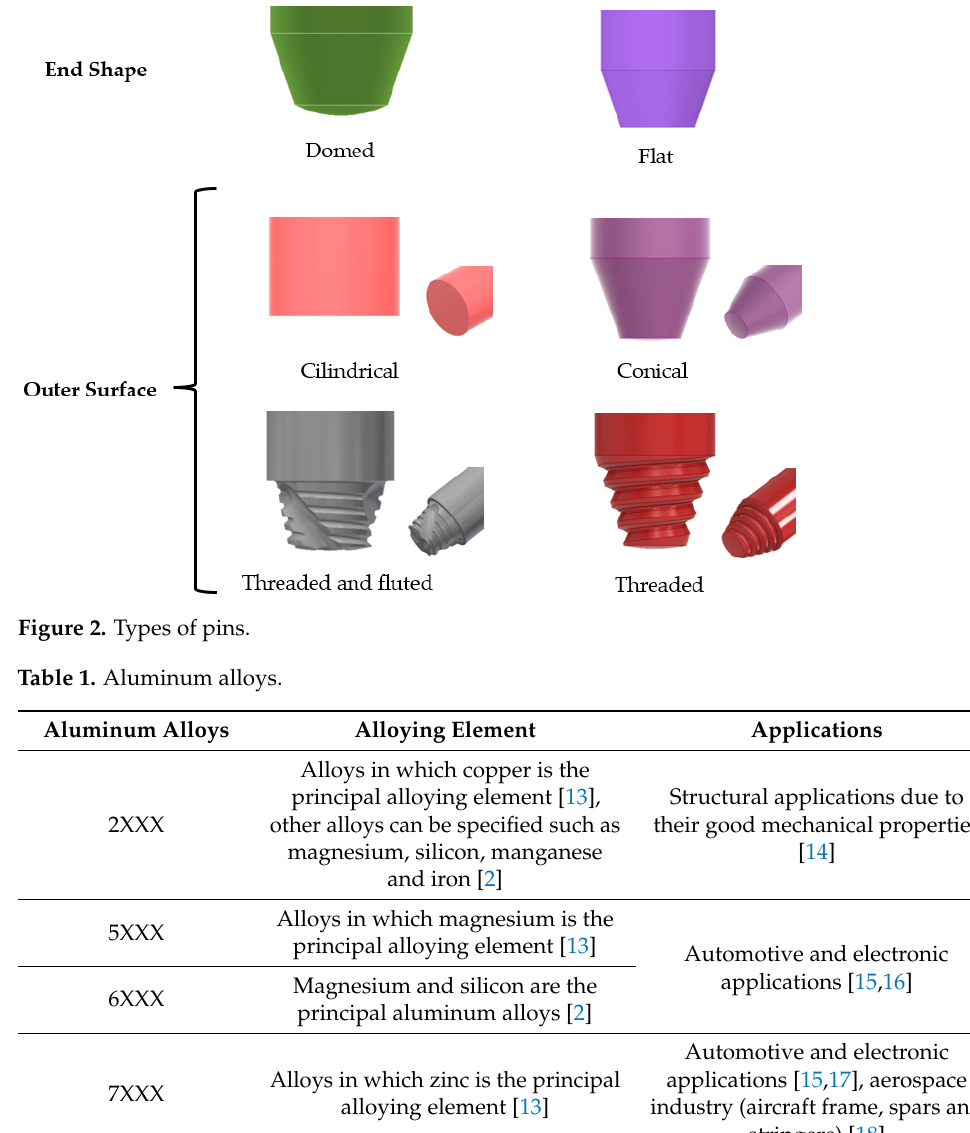
Figure 1. Types of shoulders.